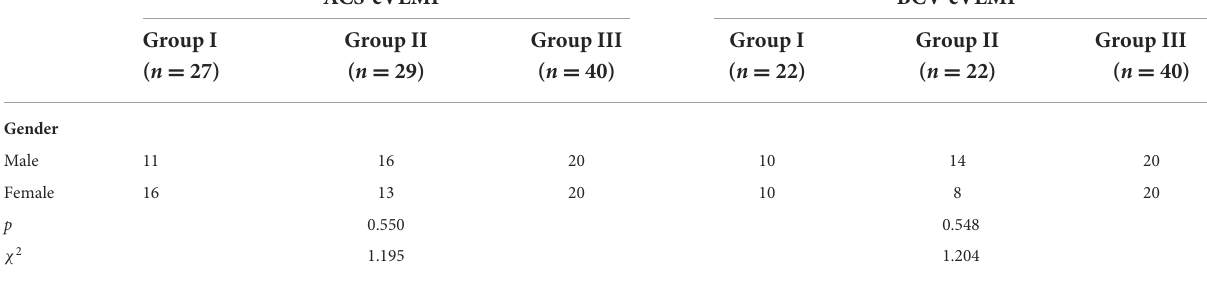
TABLE 1 Subjects characteristics in three groups.